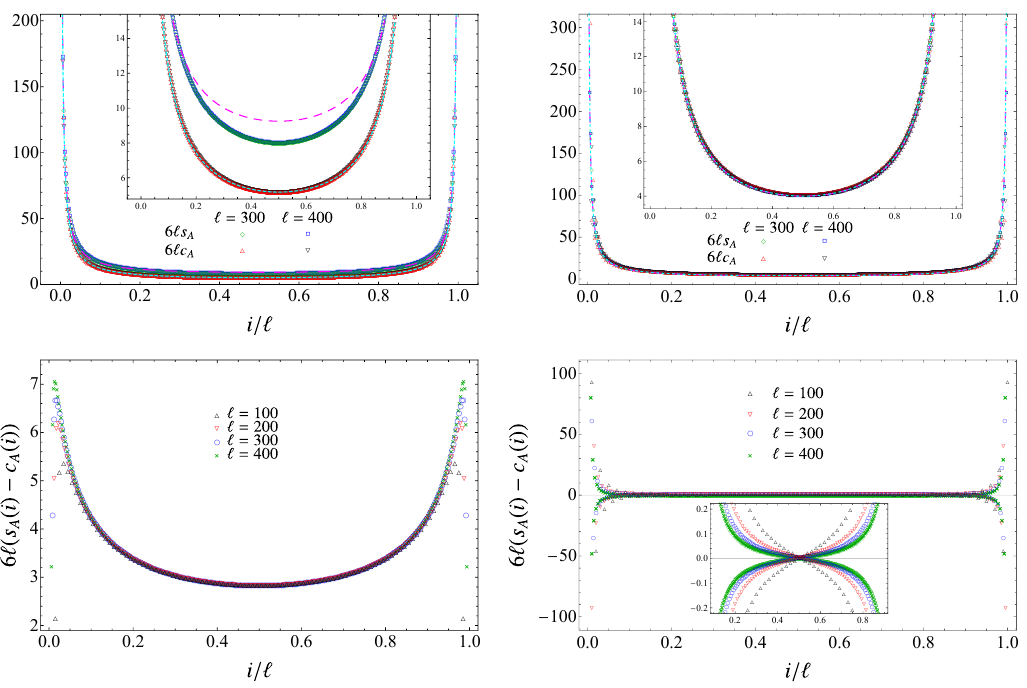
Figure 9 . Contour functions for the entanglement entropy and for the capacity of entanglement of a block made by ‘ sites in an infinite harmonic chain (left panels) and free fermionic chain (right panels) reported for various values of ‘ . In the left panel we set ω‘ = 10 − 10 . The dashed lines in the top panels represent (5.7) with c = 1 and different additive